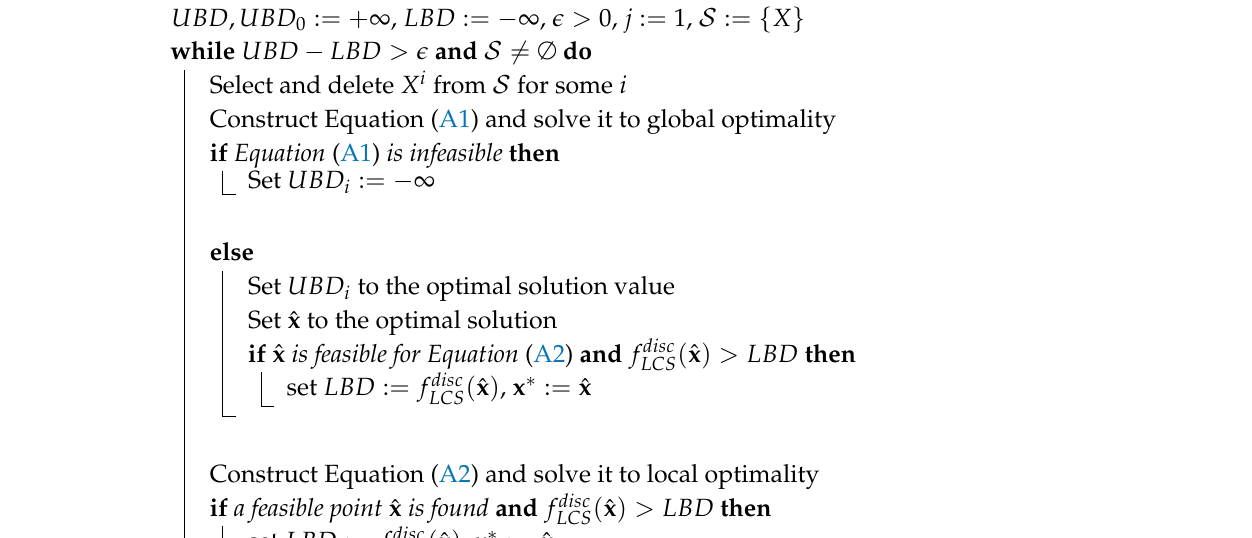
Algorithm A1: Branch & Bound